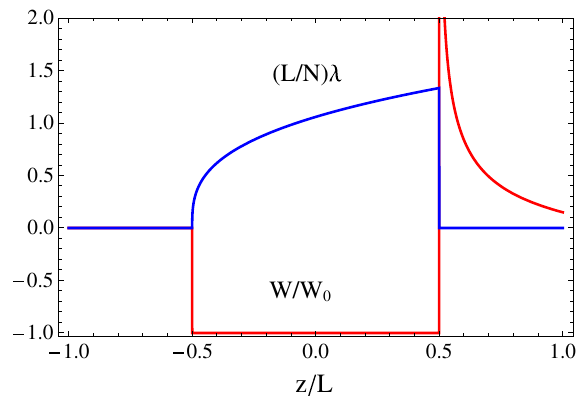
FIG. 1. (Blue) The dimensionless longitudinal density ð L=N Þ (cid:1) , where (cid:1) is given by (15). (Red) The dimensionless CSR wakefield W=W 0 , where W is given in (18) and W 0 is given in (14). Here L denotes the end-to-end bunch length and N denotes the total number of particles in the